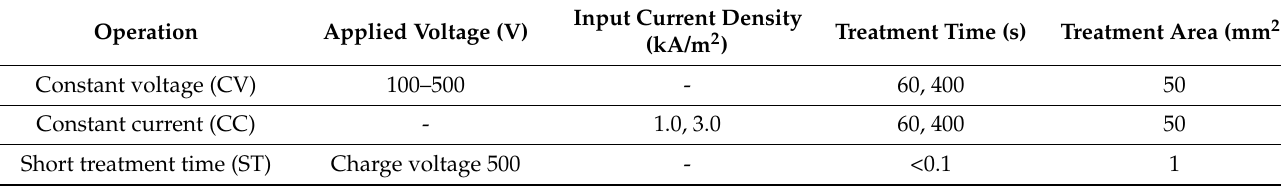
Table 1. Operating conditions of the PEO